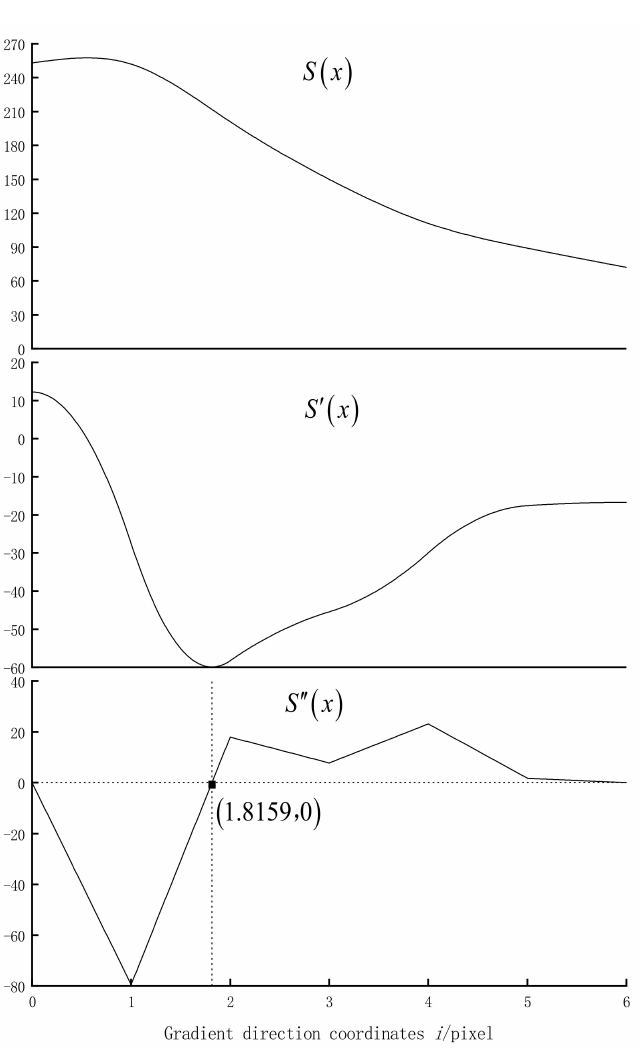
Figure 7. Image of a triple spline interpolation function and its first-order and second-order derivatives.